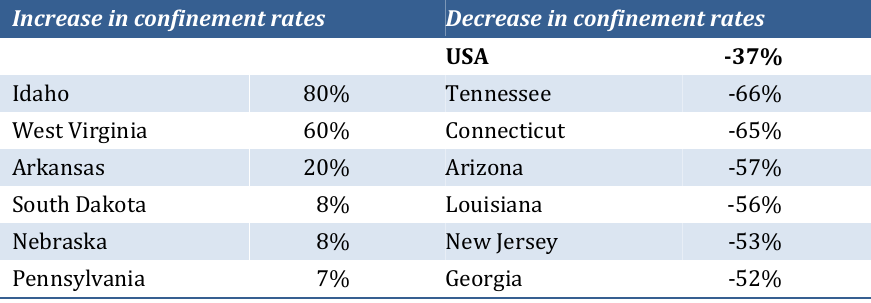
Table 3: Youth confinement in USA states, 1997 ‐ 2010 Increase in confinement rates Decrease in confinement rates